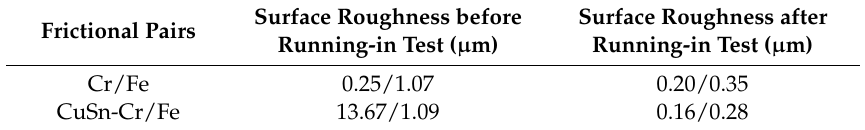
Surface Roughness before Frictional Pairs Running-in Test ( µ m)